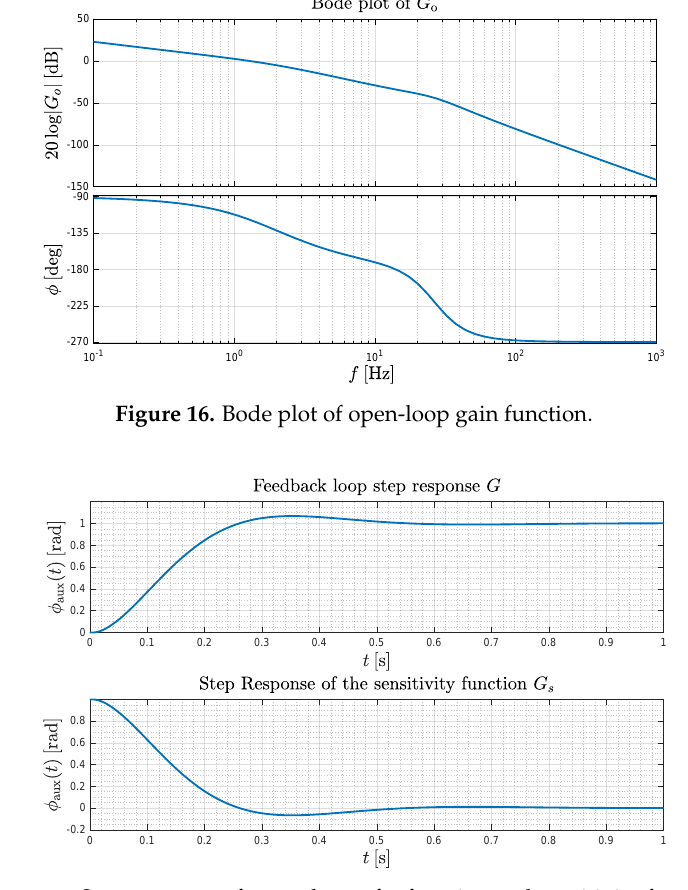
Figure 17. Step response of control transfer function and sensitivity function. Table 1. Parameters of the controlled system.